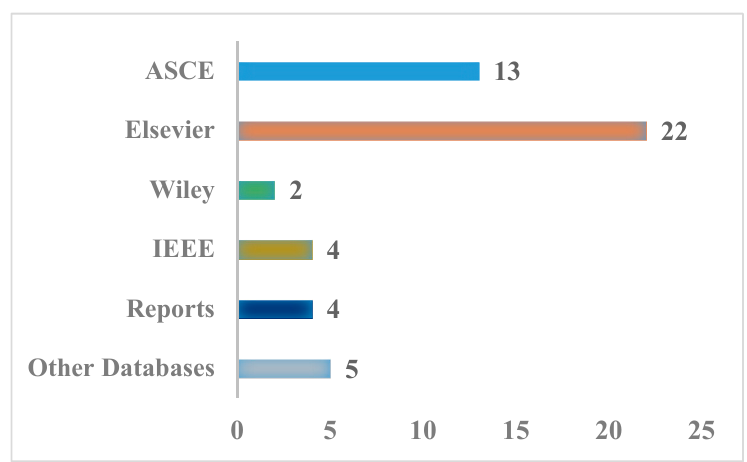
Figure 1. Number of studies on sewer inspection in databases.